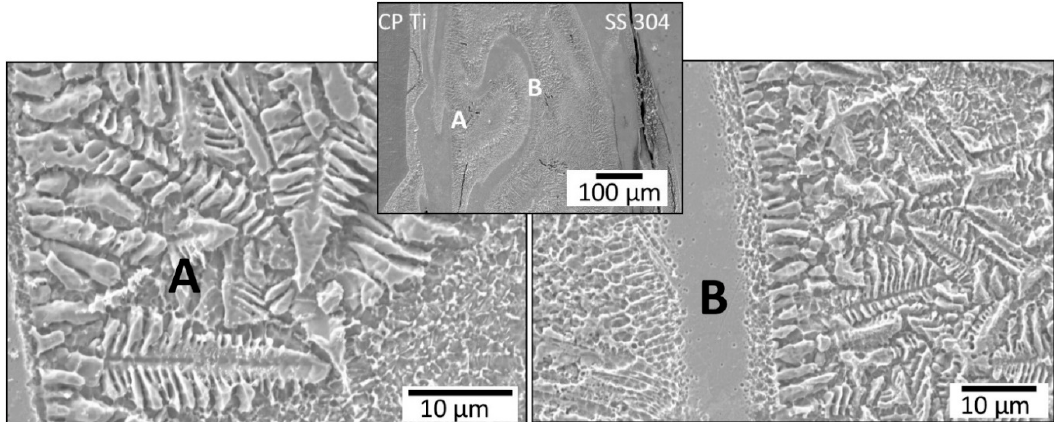
Figure 10. SEM image of LBW showing the fusion zone (FZ) and cracking on the SS304 side where ( A ) showing extensive mainly FeTi dendrite phase, and ( B ) showing a fairly smooth (Fe 1– x Cr x ) 2 Ti patch surrounded by mainly FeTi dendrites. The inset shows the general LBW profile.